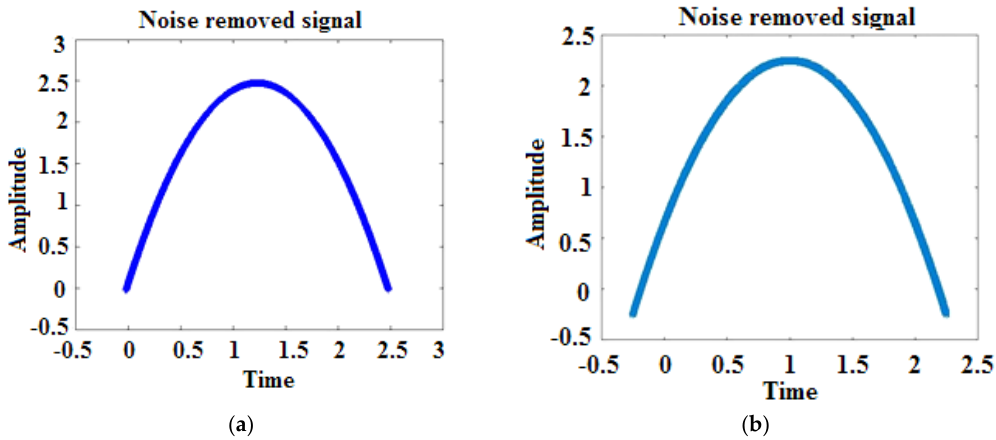
Figure 4. Noise removed signal. ( a ) Proposed method; ( b ) Existing method.